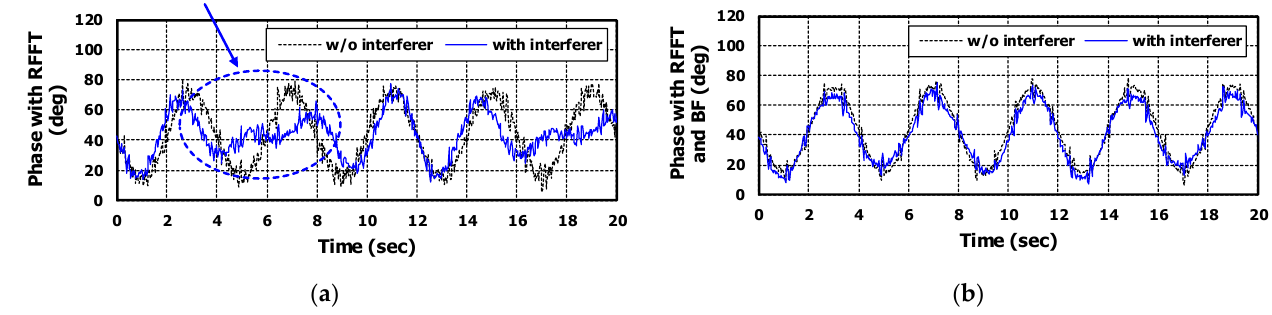
Figure 8. The simulation results for target information based on Table 2. The black dashed lines are results of the case without interferer and the blue solid lines are results of the case with interferer. ( a ) is the phase signal with applying range-FFT and ( b ) is the phase signal with applying range-FFT and beamforming.